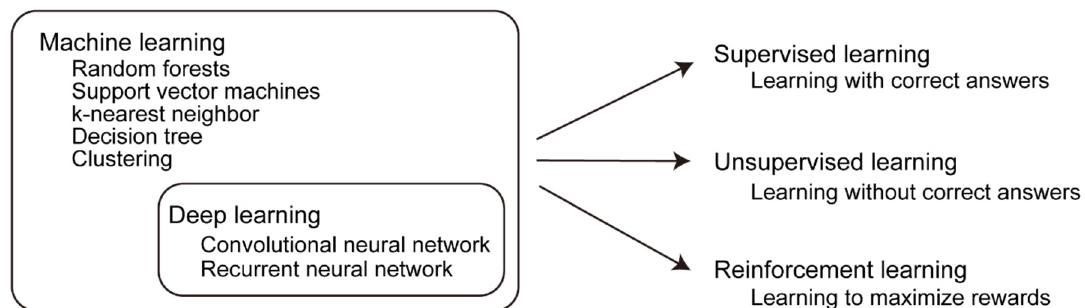
Figure 2. Various machine learning techniques.: There are various machine learning methods, such as random forests, support vector machines, k-nearest neighbor, decision tree, and clustering. Deep learning is a type of machine learning technique that consists of a multilayer neural network. There are three patterns of learning: supervised learning, unsupervised learning, and reinforce- ment learning.